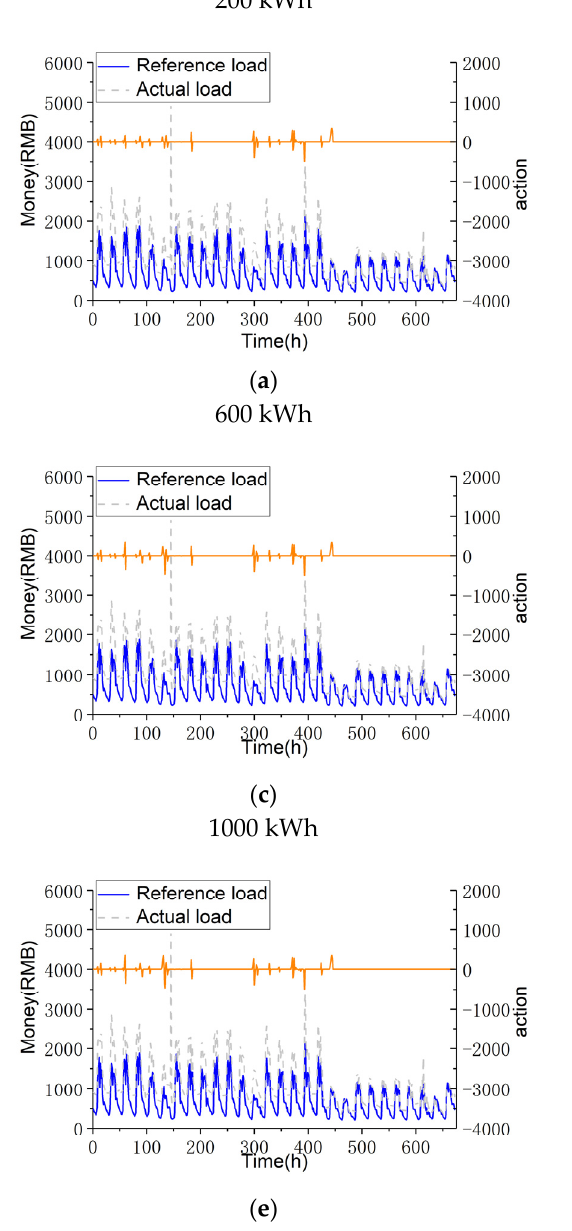
Figure 16. Optimal action and money for different BESS capacities. ( a ) 200 kWh; ( b ) 400 kWh; ( c ) 600 kWh; ( d ) 800 kWh; ( e ) 1000 kWh; ( f ) 1200 kWh.